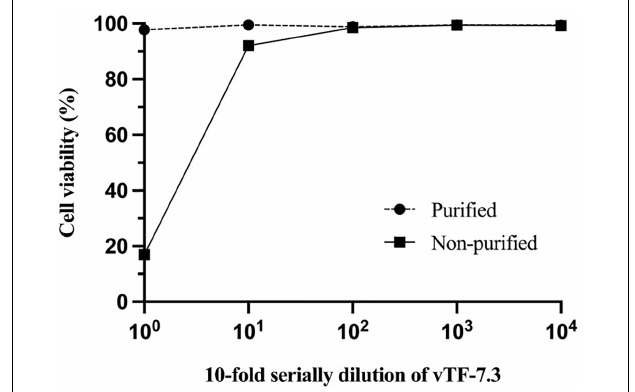
FIGURE 1 | Cell cytotoxicity studies. Monolayers of BSR-T7 cells were incubated with 10-fold serial dilution of vTF-7.3 for 1 h., respectively. 1 × DPBS was used as the solvent control. MTT assays determined cell viability. Experiments were carried out three times, and error bars reflect the standard